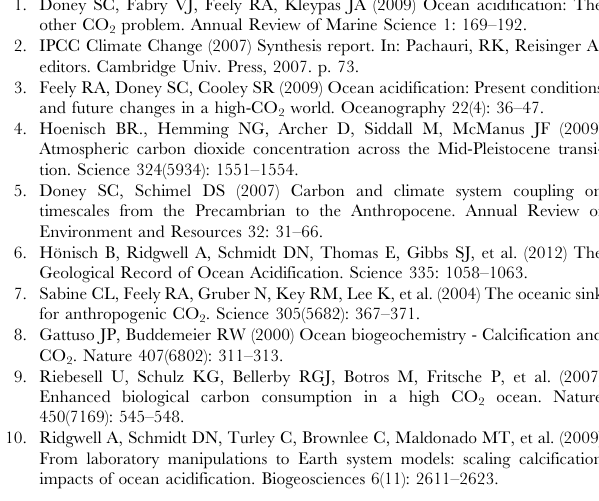
Figure S2 Close up dissecting microscope images, taken before (432 m atm) and after the 1141 m atm treat- ment incubation. A) Marginopora vertebralis , B) Amphistegina radiata , C) Heterostegina depressa , D) Peneroplis sp., individuals. Sizes are given as largest possible diameter of individuals. In A. radiata, areas of bleaching are indicated by white dashed circles. (TIF) Figure S3 Close up dissecting microscope images, taken before (432 m atm) and after the 2151 m atm treat- ment incubation. A) Marginopora vertebralis , B) Amphistegina radiata , C) Heterostegina depressa , D) Peneroplis sp., individuals. Sizes are stated as largest possible diameter of individuals. Both A. radiata and H. depressa showed signs of bleaching. Symbiont clumping in A. radiata is indicated by white dashed circles. (TIF) Figure S4 Box-plots representing the 25 th , 50 th and 75 th percentiles of D Ca 2 + , calculated from profiles measured during the pCO 2 treatment incubation, at light (30 m mol photons m 2 2 s 2 1 ) and dark conditions for individual species. Note the different scales between A) photosymbiotic and B) symbiont-free species. Outliers ( . 1.5 interquartile range) and extreme values ( . 3 times interquartile range) are indicated by (O) and (*) respectively.